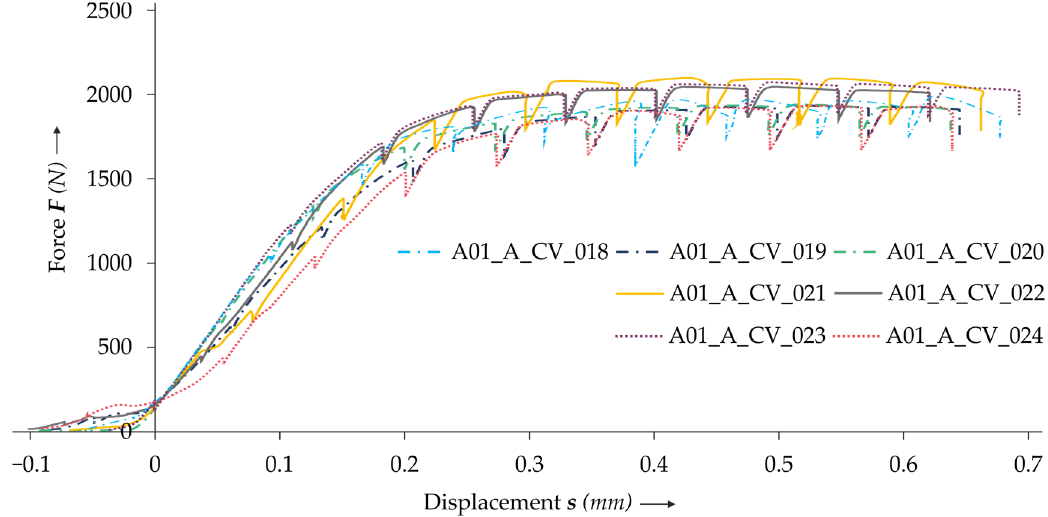
Figure 7. The results of the lap shear tests using specimens with one sheet treated (dash-dot line), with both sheets treated